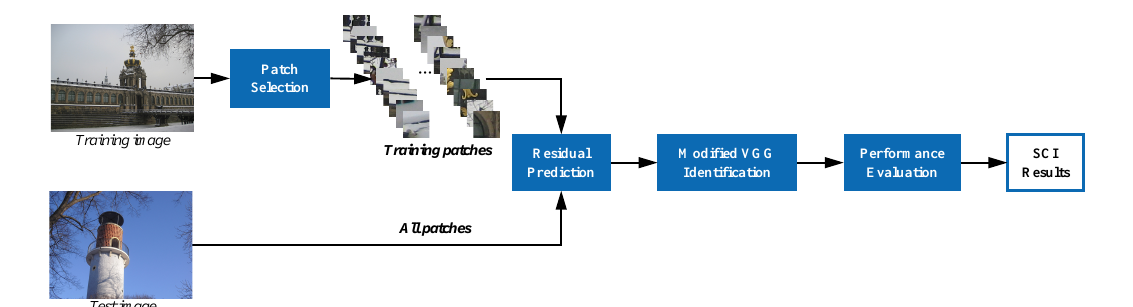
Figure 1. Framework of the proposed source camera identification